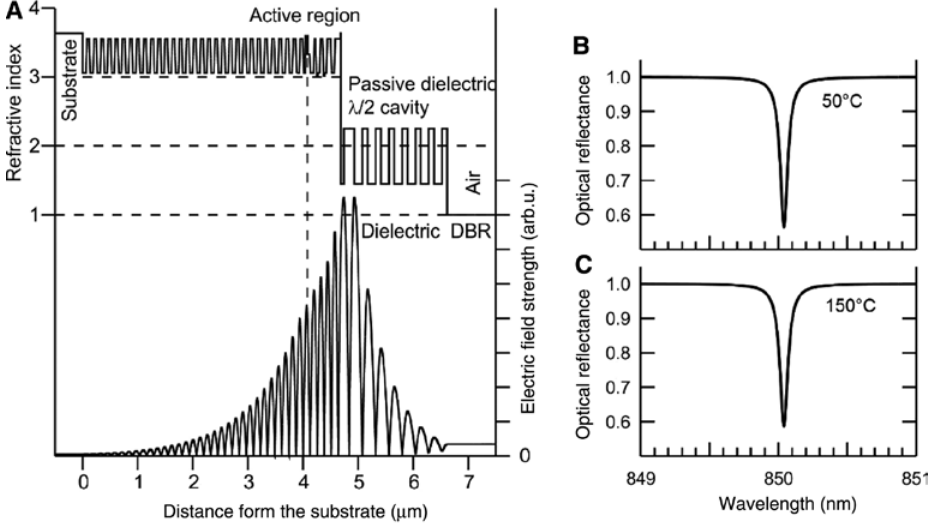
Figure 5: (A) Modeled vertical refractive index profile and optical field profile for a designed passive cavity surface emitting laser. (B) Modeled optical power reflectance (OR) spectrum of the structure of (A) at 50 ° C. (C) Modeled OR spectrum of the same structure at 150 °